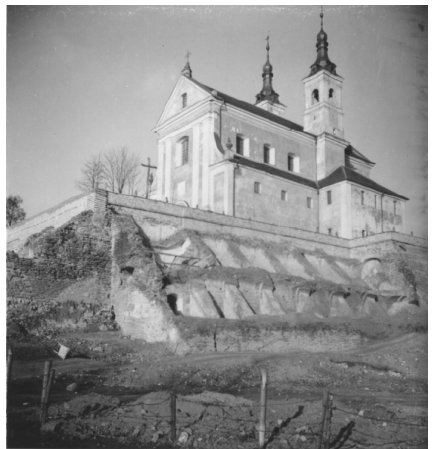
Fig. 5. Arrangement of sub-base investigation bore holes